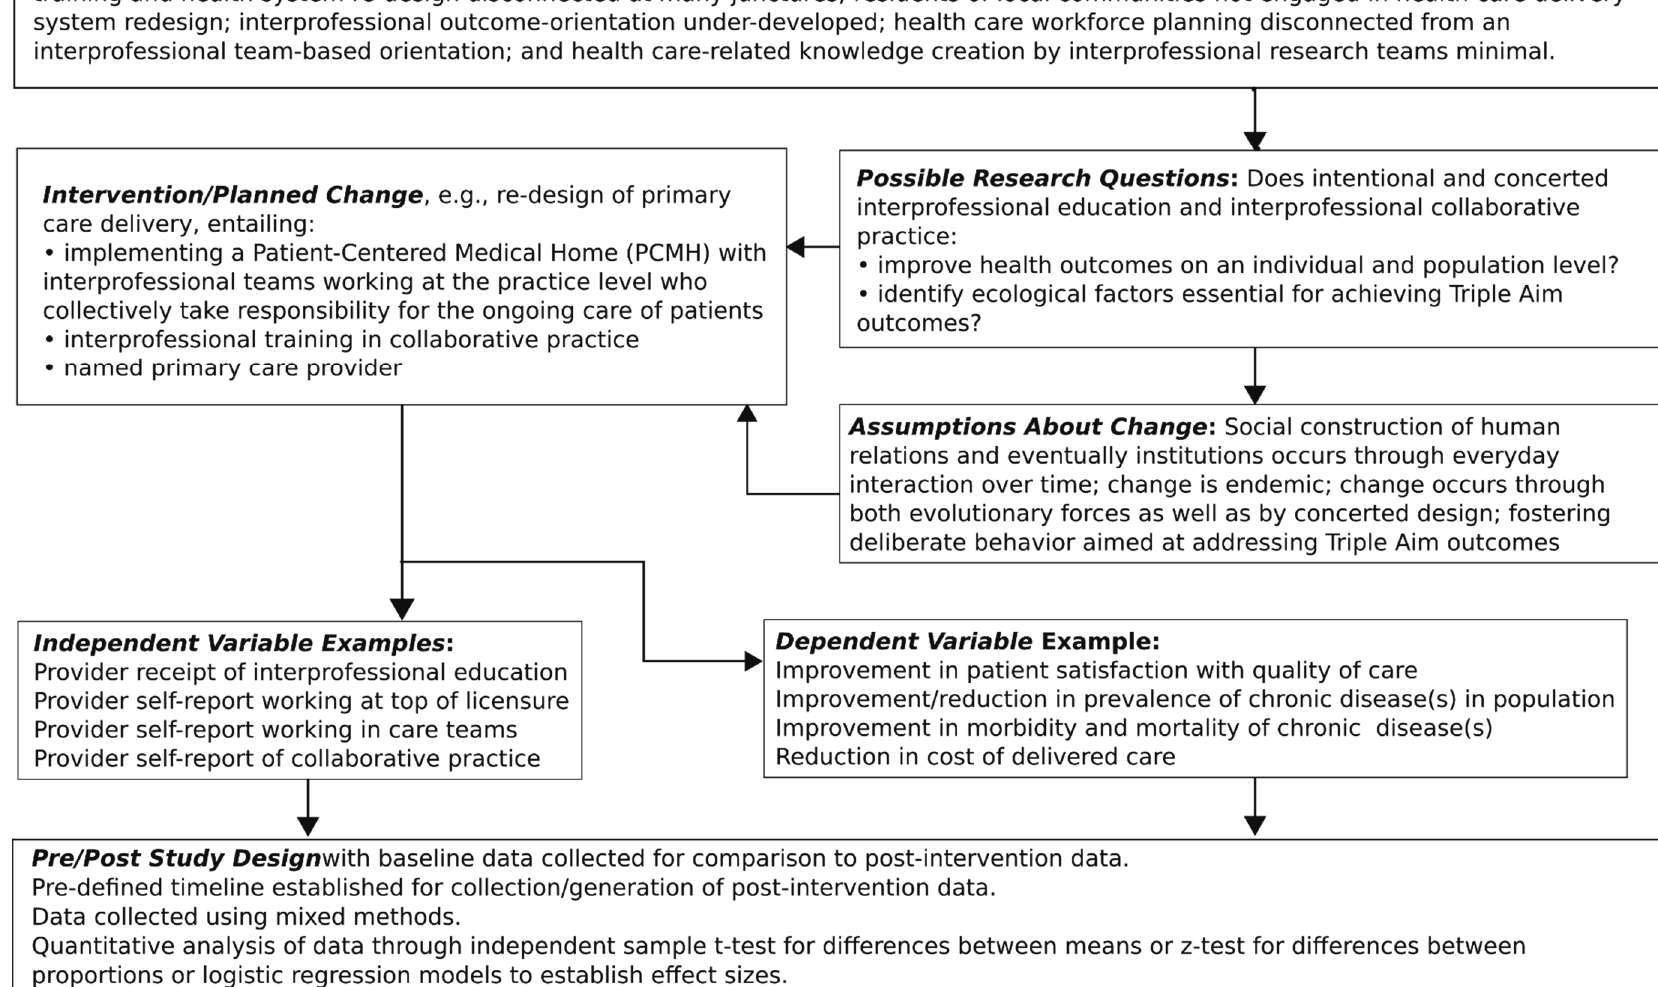
Figure 1. Illustration of intervention design and research